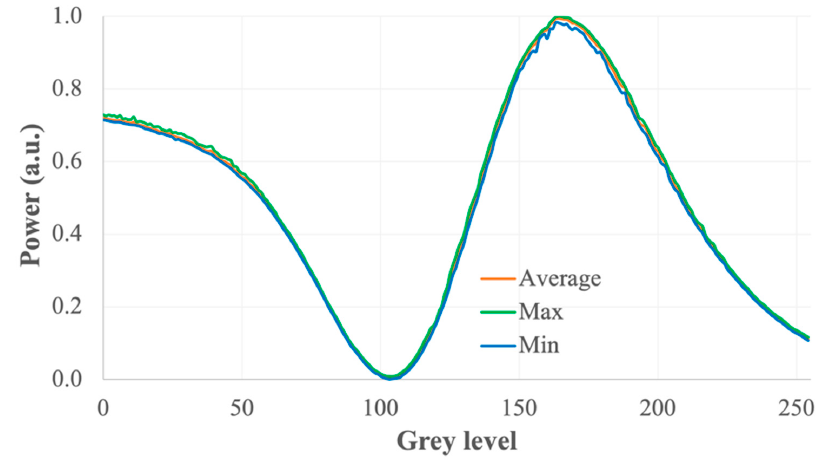
Figure 6. The experimental power response of the LCOS device.